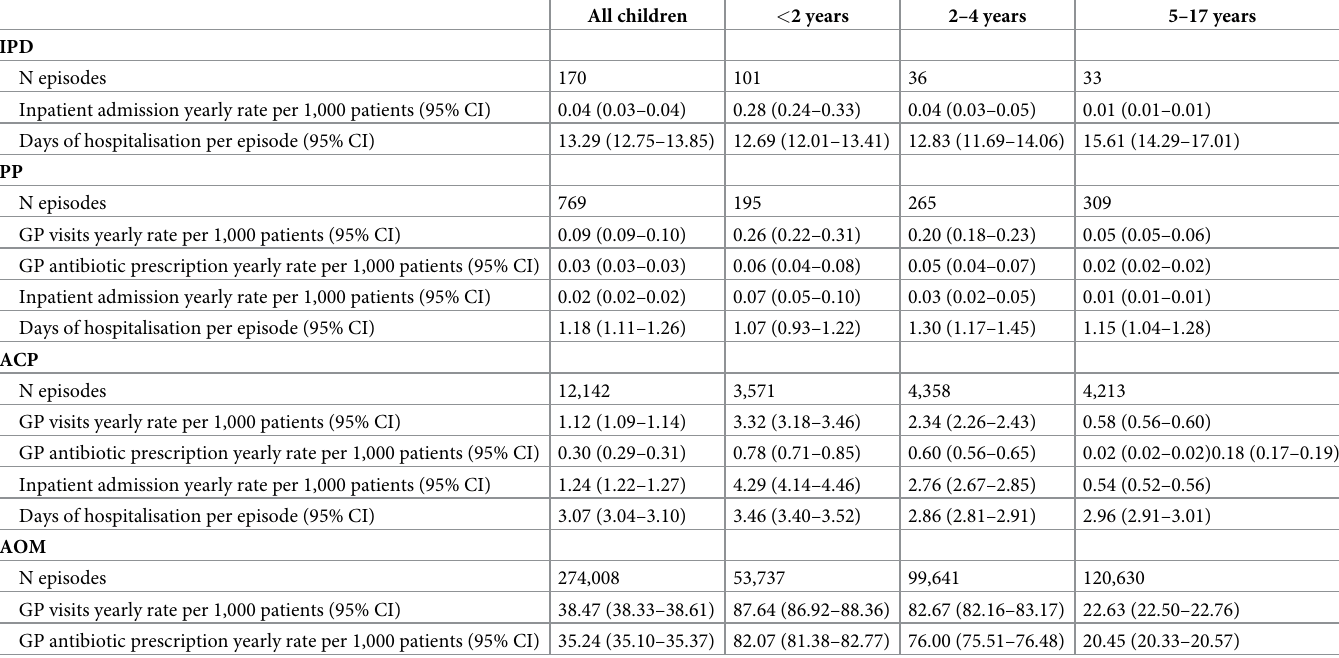
Table 2. IPD, PP, ACP and AOM HCRU by age groups overall the study period (2003–2019).